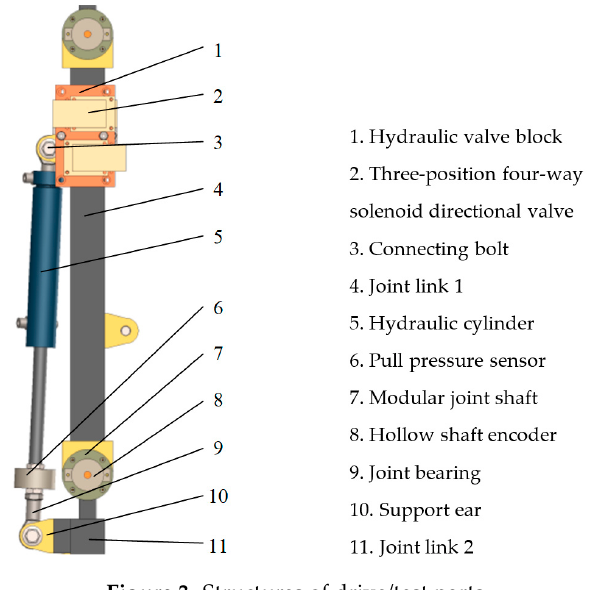
Figure 3. Structures of drive/test parts.